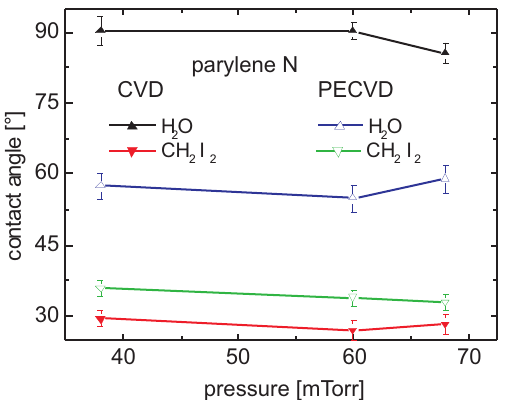
Figure 21. Contact angle as function of reactor pressure. Different shape of the contact angle for parylene N (CVD and PECVD). The CVD coating is significantly more hydrophobic than the PECVD one, but also more lipophilic.